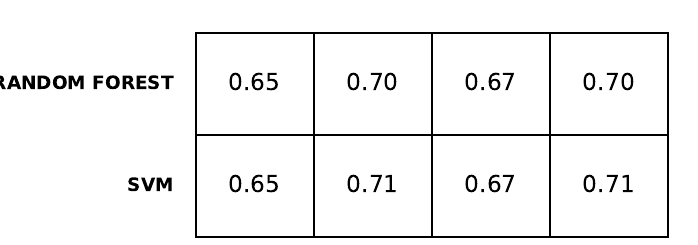
Figure 8. Results of the prediction of obsessive and compulsive